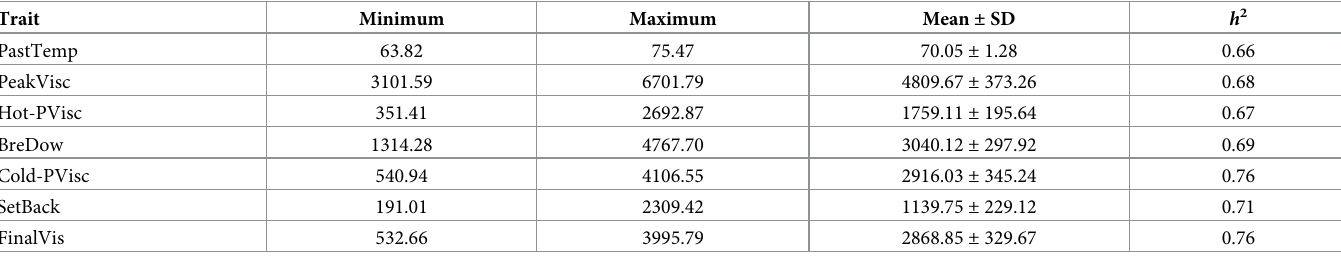
Table 1. Minimum, maximum, and mean values of best linear unbiased predictors (BLUPs) and broad-sense heritability ( h 2 ) for the pasting properties of cassava starch. Trait Minimum Maximum PastTemp 63.82 PeakVisc Hot-PVisc BreDow Cold-PVisc 540.94 SetBack 191.01 FinalVis 532.66 PastTemp: pasting temperature (˚C); PeakVisc: peak viscosity (cP); Hot-PVisc: hot-paste viscosity (cP); BreDow: breakdown viscosity (cP); Cold-PVisc: